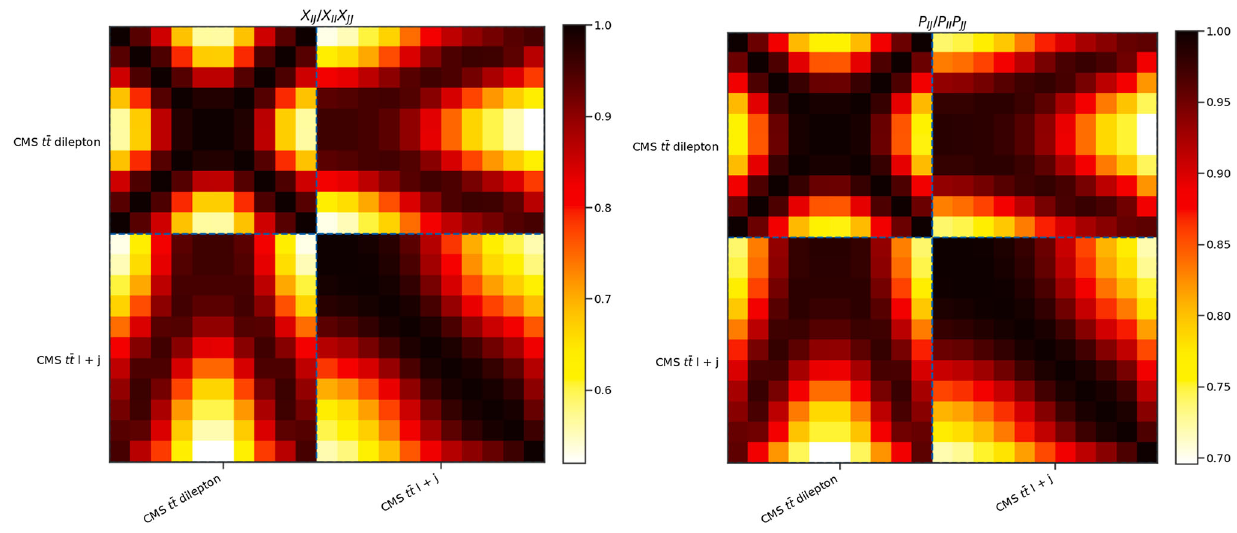
(cid:12) (cid:7) P (cid:7) P II JJ of the total